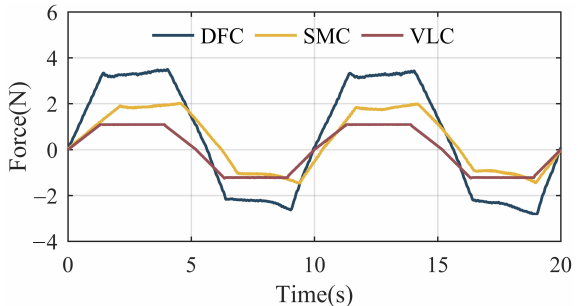
Figure 12. Interaction force curves with different control strategies.